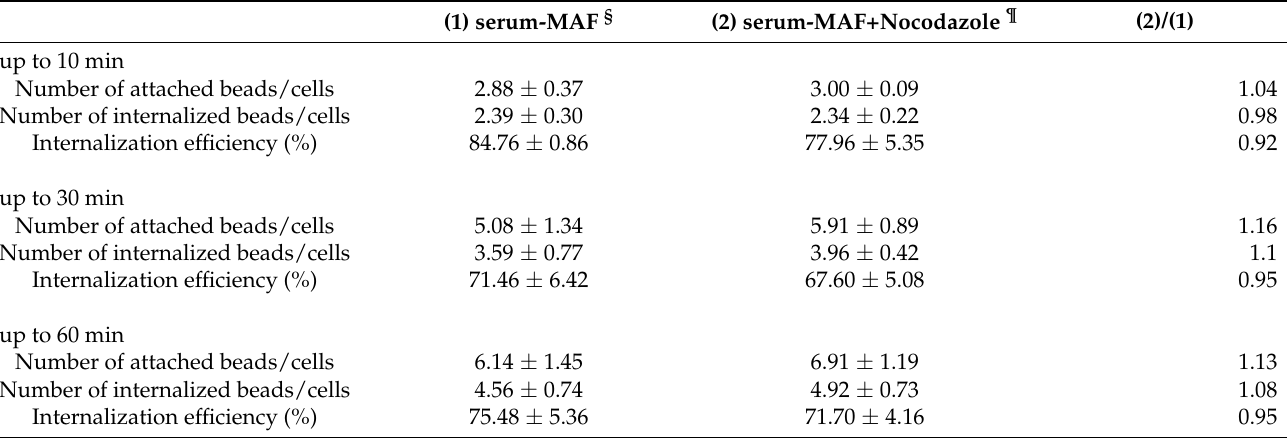
Table 3. Effect of microtubule destabilization on the bead’s internalization process in the serum-MAF- activated